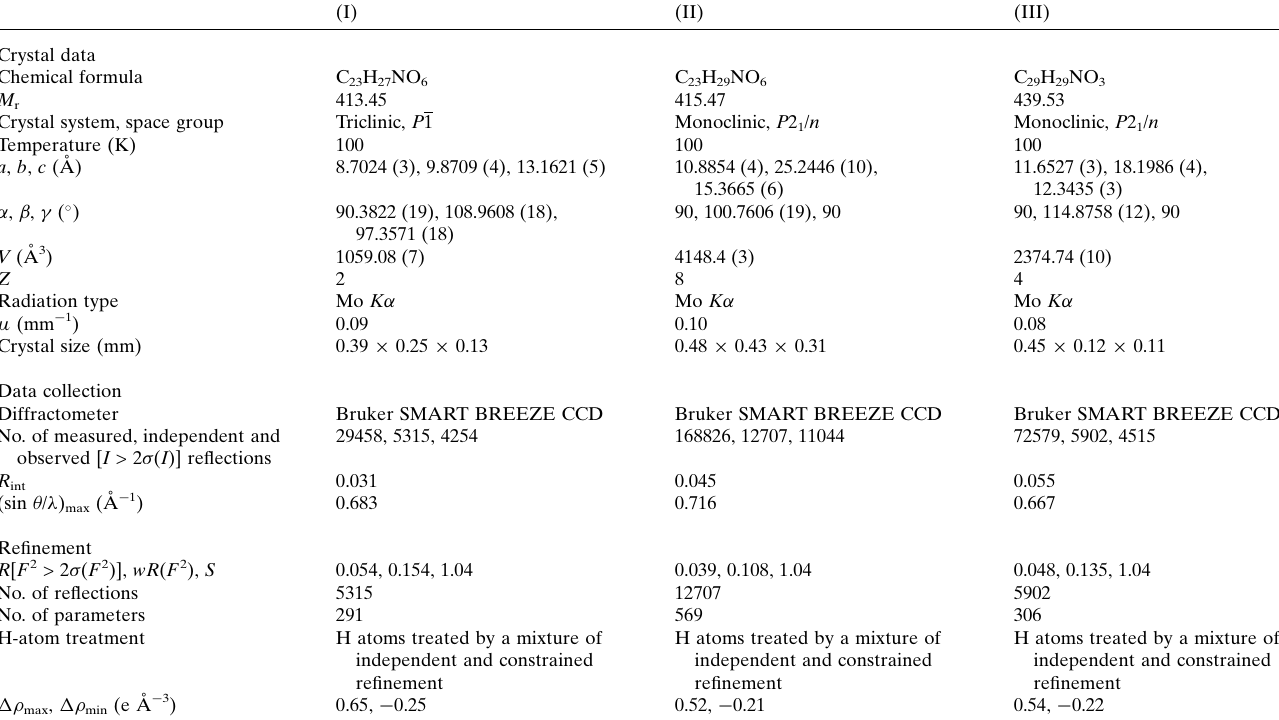
Table 4 Experimental details.